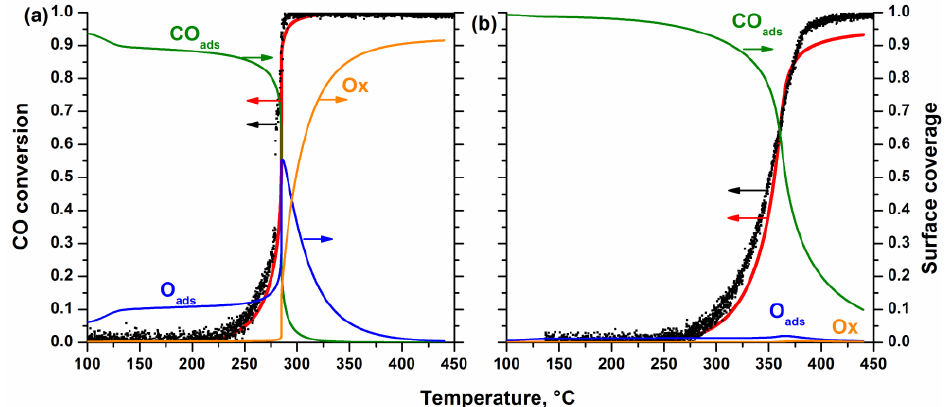
Figure 8. Temperature dependencies of CO conversion and the coverages of the Pt foil surface with adsorbed CO, O and oxide species at the O 2 /CO ratio ( a ) 5 and ( b ) 0.5. The inlet concentration of CO was 0.2 vol.%. The dotted black curves correspond to the CO conversion during the kinetic experiments, while the solid red curves are the results of the CO conversion modelling. The fitted kinetic parameters are k 1 = 6.75 × 10 4 s − 1 · mbar − 1 , k − 1 = 8 × 10 8 e − 13 RT s − 1 , k 2 = 750 s − 1 · mbar − 1 , k 3 = 3 × 10 12 e − 27 RT s − 1 , k 4 = 10 12 e − 25 RT s − 1 , and k 5 = 1.5 × 10 13 e − 25 RT s − 1 · bar − 1